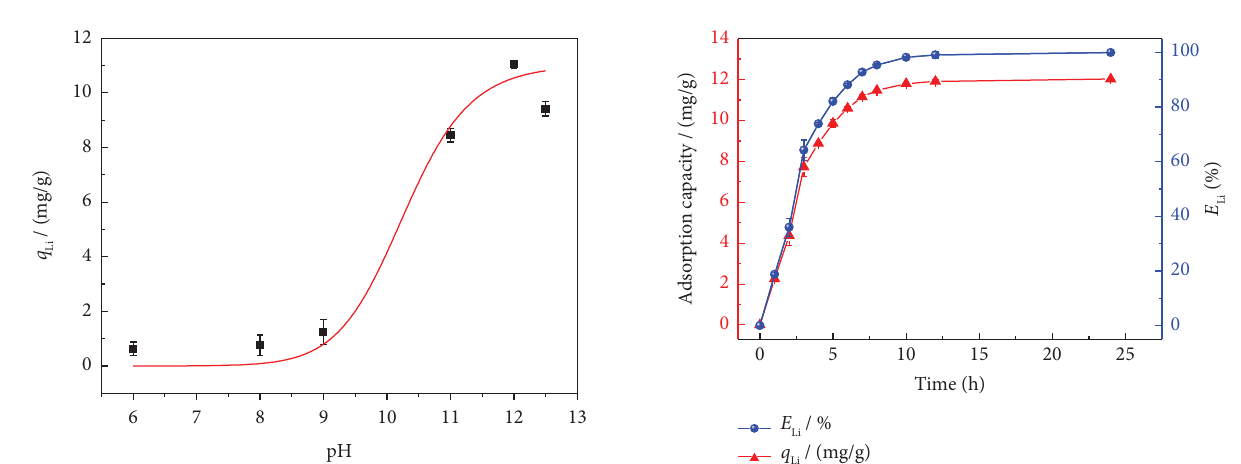
Figure 9: CMC-HTO-EGDE-ME: time efect for Li + adsorption from geothermal